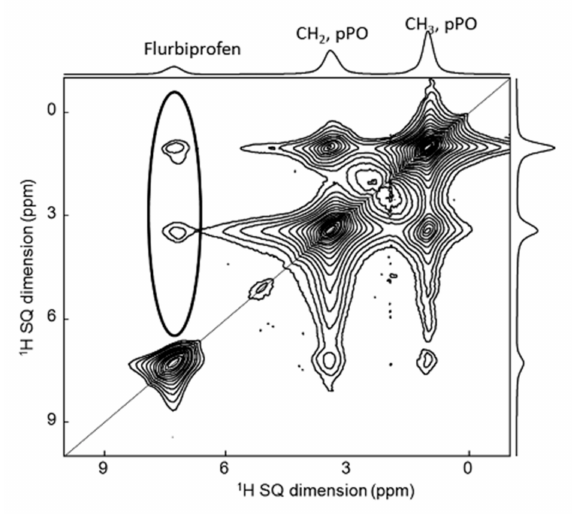
Figure 4. 1 H- 1 H 2D SQ-SQ MAS NMR of flurbiprofen incorporated in silica capsules filled with Pluronic P123. As evidence (ringed), the cross-peaks presented between the protons of the drug and the ones of the DDS